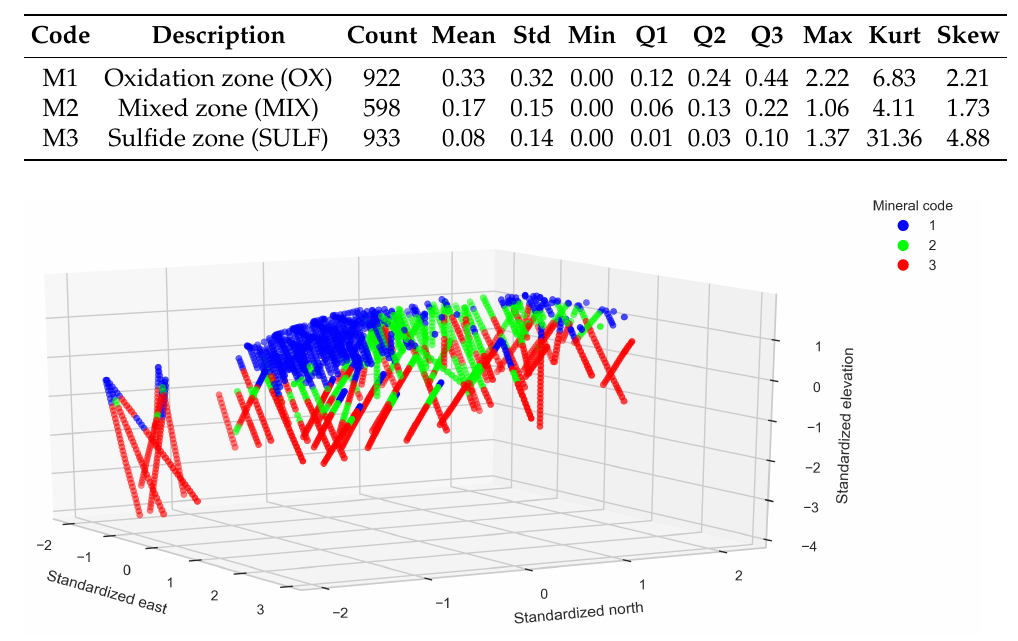
Table 1. Au statistics (ppm) by mineral zone.